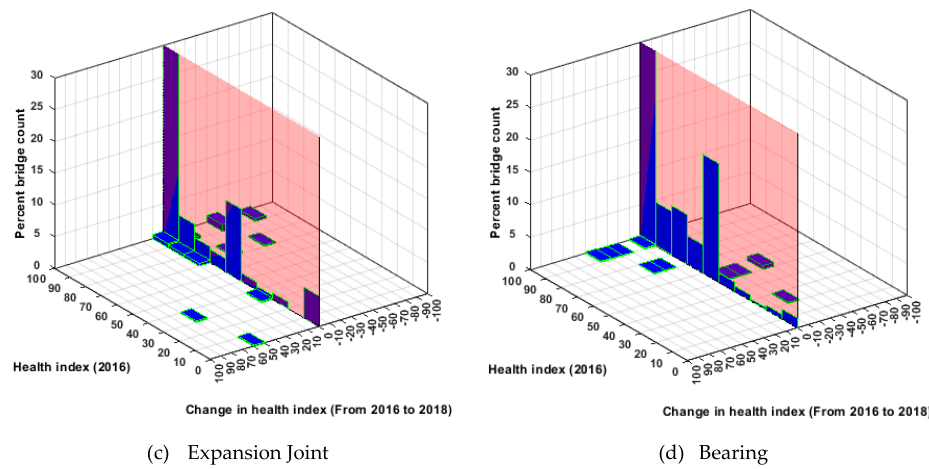
Figure 12. NHS bridge performance in Pennsylvania. ( a ) Overall bridge; ( b ) concrete deck; ( c ) expansion joint; ( d ) bearing.